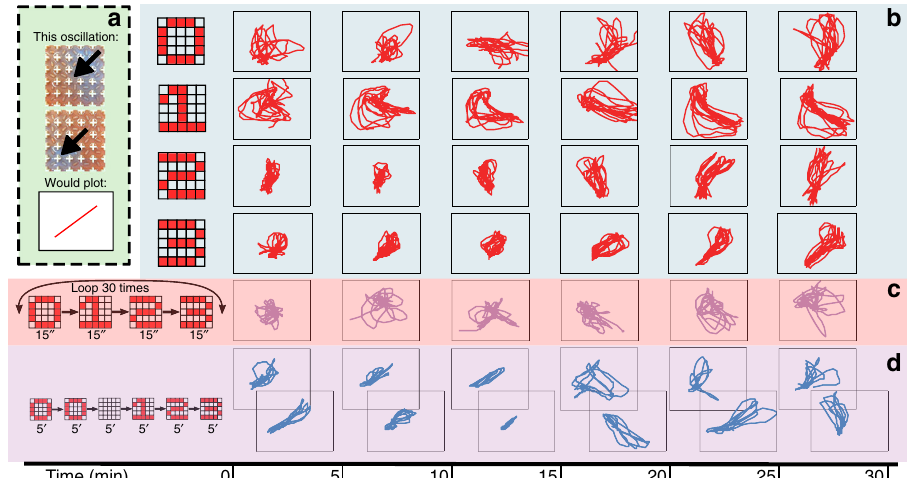
Fig. 3 Programming the platform by introducing different input patterns during execution. a For every frame in a video, the centre of mass (CoM) of a BZ oscillation was calculated using the blue channel of the frame, and then as these CoMs translated between frames, we plotted their translations using straight lines. Thus, each of the plots in this fi gure represents how the BZ oscillations moved across the arena. b In these four rows an experiment was performed where the same input pattern was applied to the BZ medium for 30 min. c In the following rows, two different experiments were performed where the pattern inputted to the BZ medium changed dynamically. In the fi rst case, it iterated in a loop where every minute-long iteration inputted each of the four patterns in a sequence where each pattern was inputted for 15 s. d In the second case, each pattern was inputted only once: initially 0 for 10 min, then nothing for 5 min, and then 1, 2 and 3 for 5 min